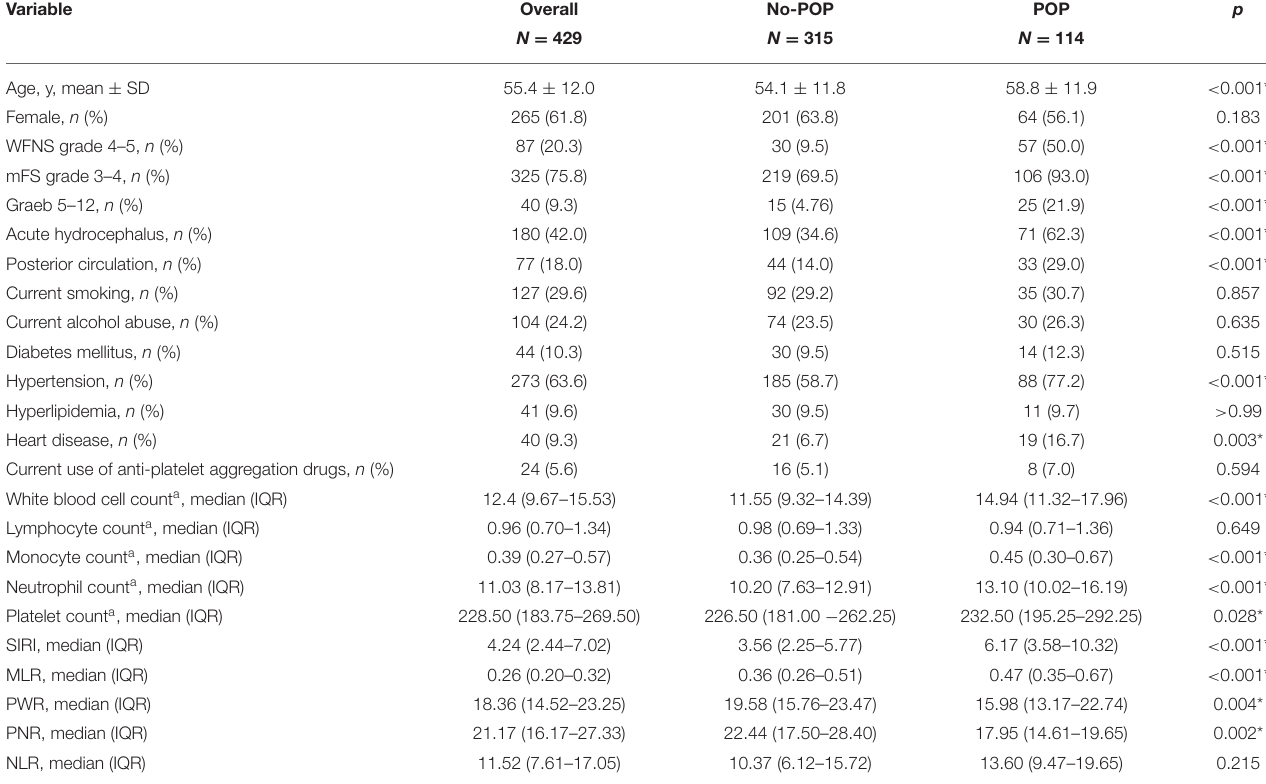
TABLE 4 | Baseline characteristics and inflammatory biomarkers in the endovascular coiling EC